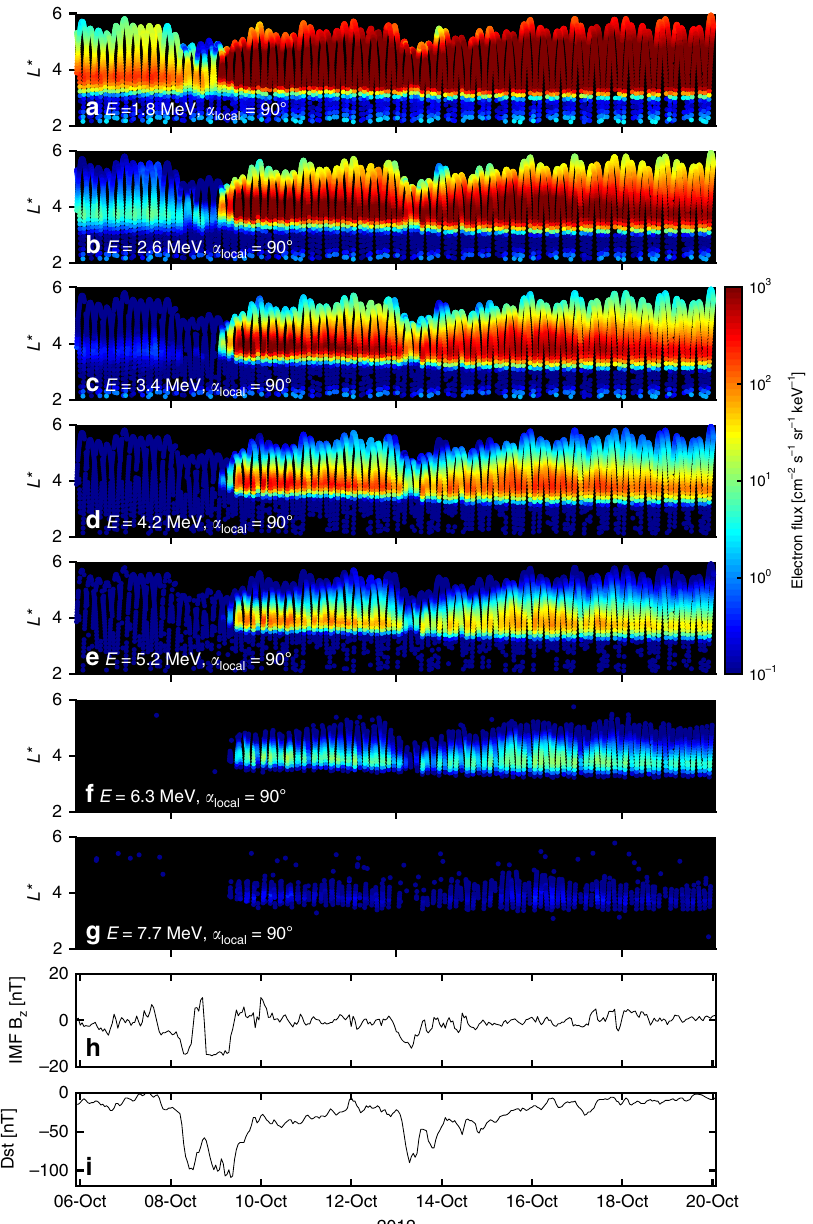
Fig. 1 An overview of the radiation belt electron fl ux across a number of energies during 6 – 20 October 2012. a – g Show the electron fl ux measured by the REPT instrument on NASA ’ s Van Allen Probe A and B for electron energies from 1.8 to 7.7MeV. The fl ux corresponds to a local pitch angle of 90° and the associated L * coordinate has been calculated using the TS07 magnetic fi eld model 27 . Only electron fl ux measurements above the noise fl oors 28 of REPT 17 have been shown. h Shows the evolution of the north – south component (relative to the Earth ’ s magnetic fi eld) of the interplanetary magnetic fi eld (IMF B z ) for the period, and i shows the disturbance storm time index (Dst), a measure of the geomagnetic storm intensity. The geomagnetic activity on the 9 October, resulting from a period of strongly negative IMF B z , produced an enhancement in the electron fl ux over a broad energy range, including at